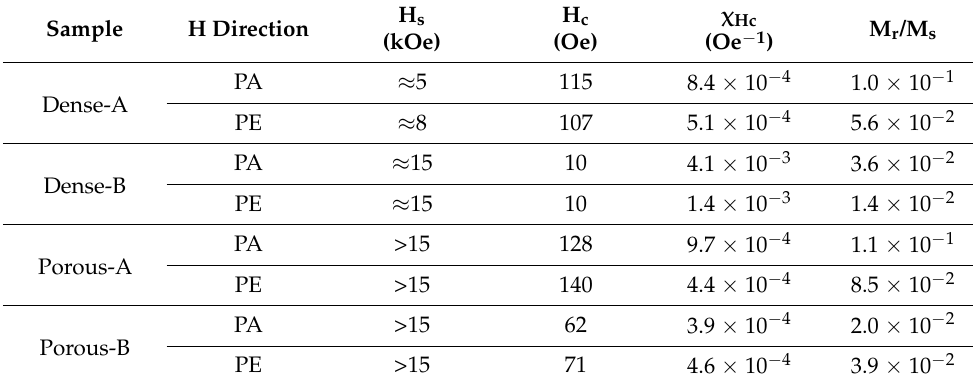
Table 2. Magnetic properties evaluated from hysteresis loops reported in Figures 8 and 9. Saturation field (H s ), coercive field (H c ), magnetic susceptibility evaluated at the coercive field χ Hc , and the normalized magnetization remanence (M r /M s ). The nomenclature for the NW arrays is the same as in Table 1.